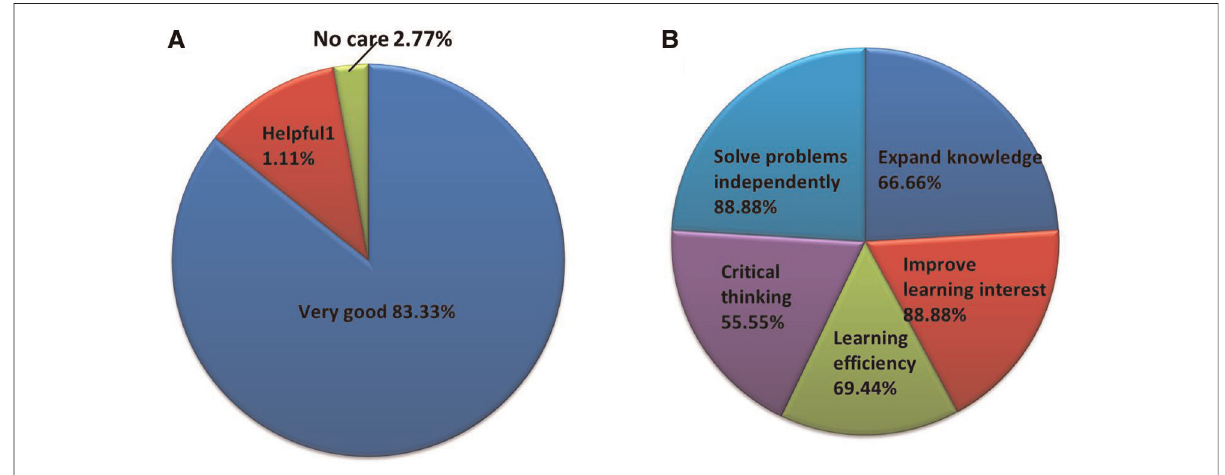
FIGURE 4 Students ’ partial feedback on the questionnaire. ( A ) Attitude towards CBL teaching method; ( B ) Capacity improvement